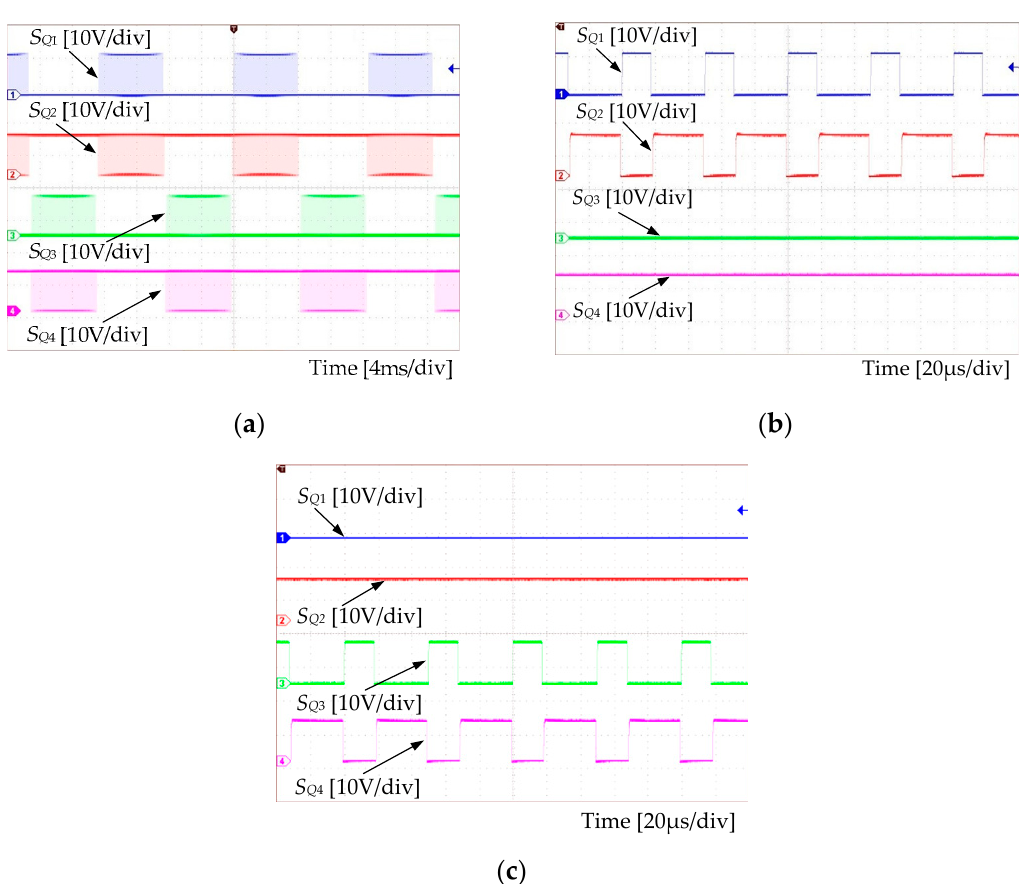
Figure 11. SSBBI's driving signals: ( a ) At the line period scale, ( b ) during positive half-line cycle (at